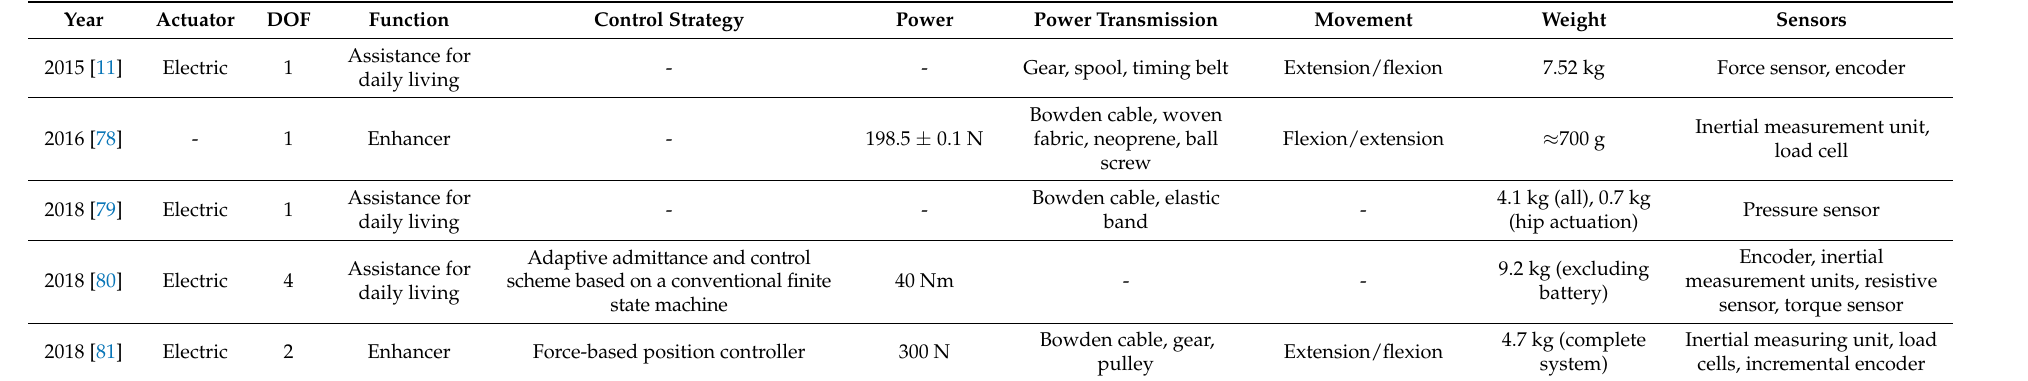
Table 5. Development of soft exoskeletons for the hip.